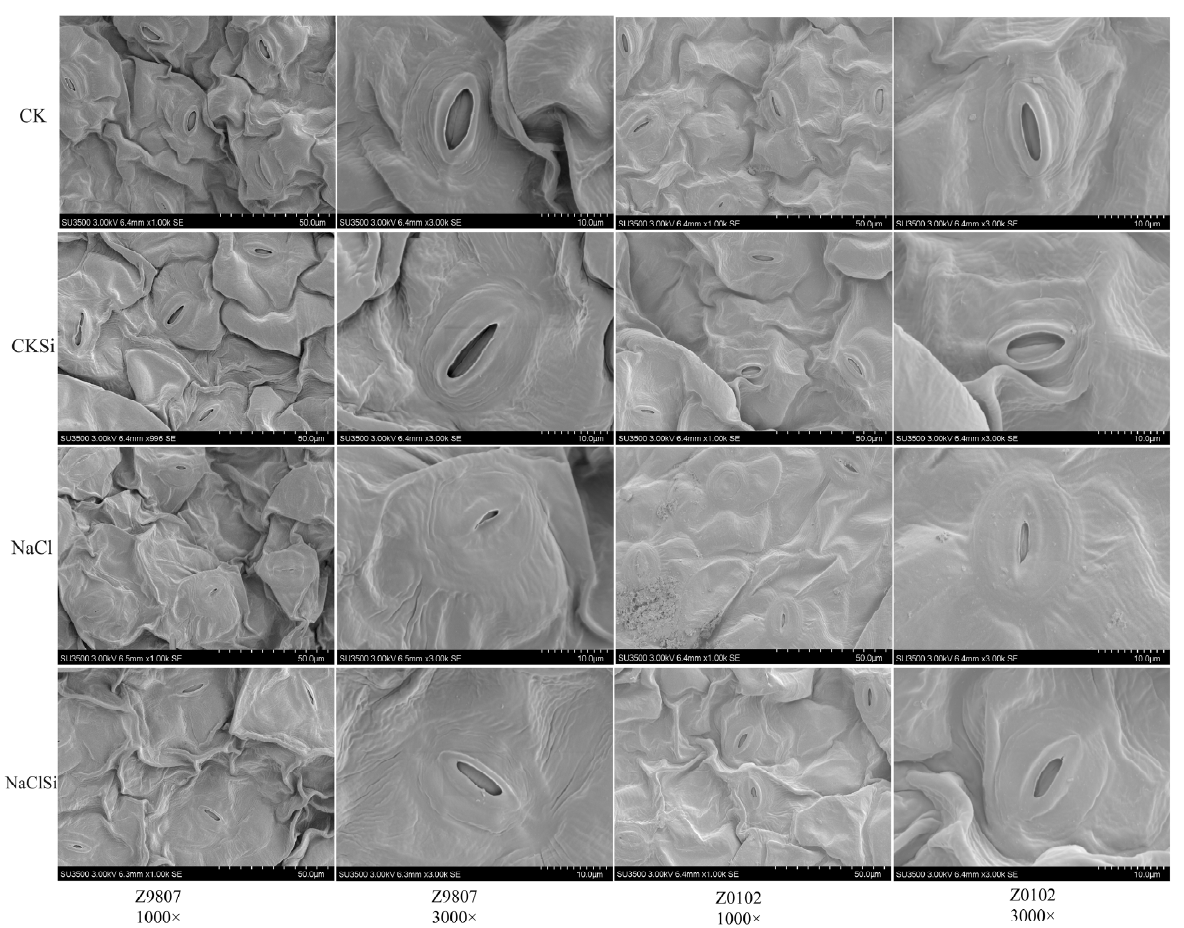
Figure 6. Effect of exogenous Si on the stomatal state of Z0102 and Z9807 leaves under saline and non-saline conditions. Comparison of the stomatal state was observed using a scanning electron microscope (SEM) image.